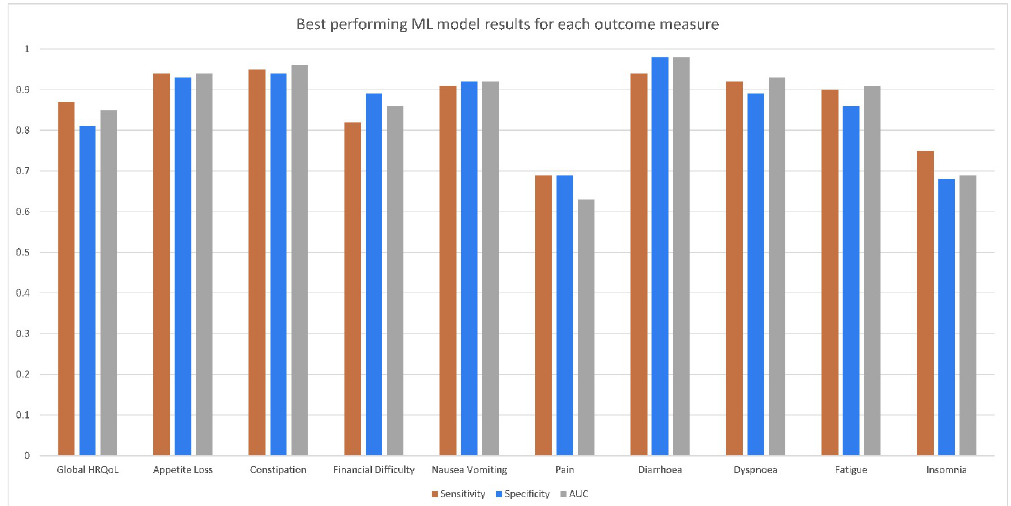
Fig 1. Optimal model performance metrics across the different outcome